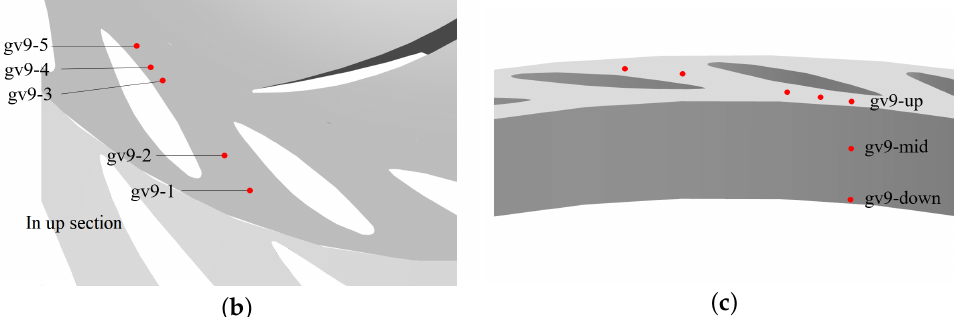
Figure 11. Layout of pressure-monitoring points for numerical calculations. ( a ) Monitoring points along the circumference. ( b ) Along passage of guide vane. ( c ) Along vertical heights.